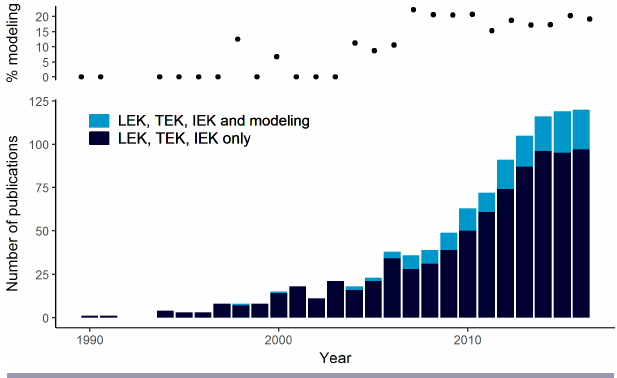
Fig. 1 . Annual number of scientific publications (articles and reviews) retrieved by searching the Scopus database for “local ecological knowledge” or “traditional ecological knowledge” or “indigenous ecological knowledge” and “model(l)ing” in the title, summary, or keywords (1990–2016). Dots in the top panel indicate the annual percentage of publications including a